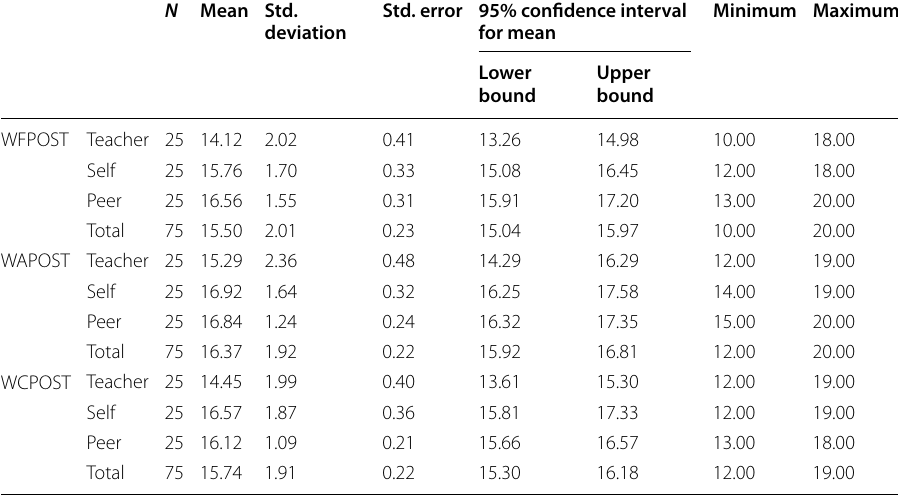
Table 8 Descriptive statistics of all groups on the posttests of writing accuracy, fluency, and complexity N Mean Std. deviation